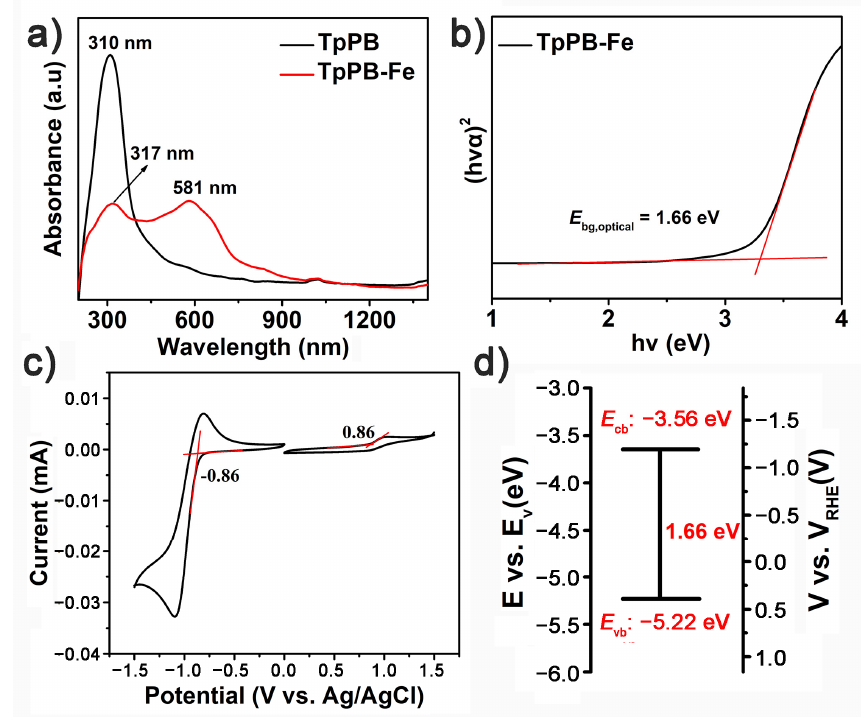
Figure 4. ( a ) The UV–Vis spectra of TpPB and TpPB-Fe; ( b ) bandgap ( E bg, optical ) of TpPB-Fe deter- mined from the Kubelka–Munk-transformed reflectance spectra for TpPB-Fe; ( c ) cyclic voltammo- gram (CV) curve of TpPB-Fe; ( d ) band structure diagram for TpPB-Fe.